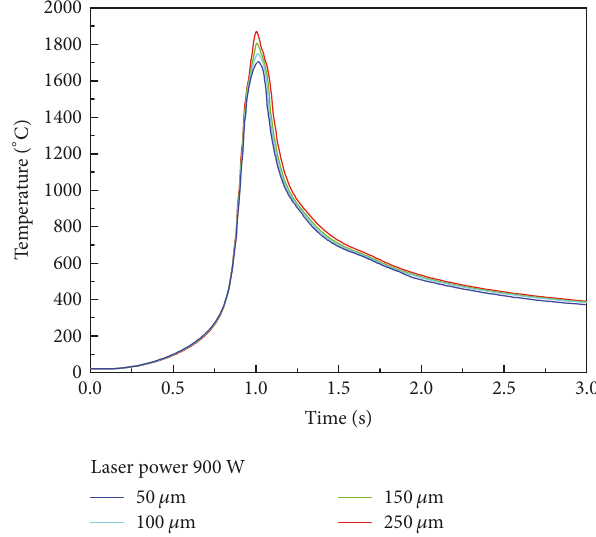
Figure 9: Influence of the laser offset on the time history of temperatures in the node 𝑃 for the laser power of 900 W.